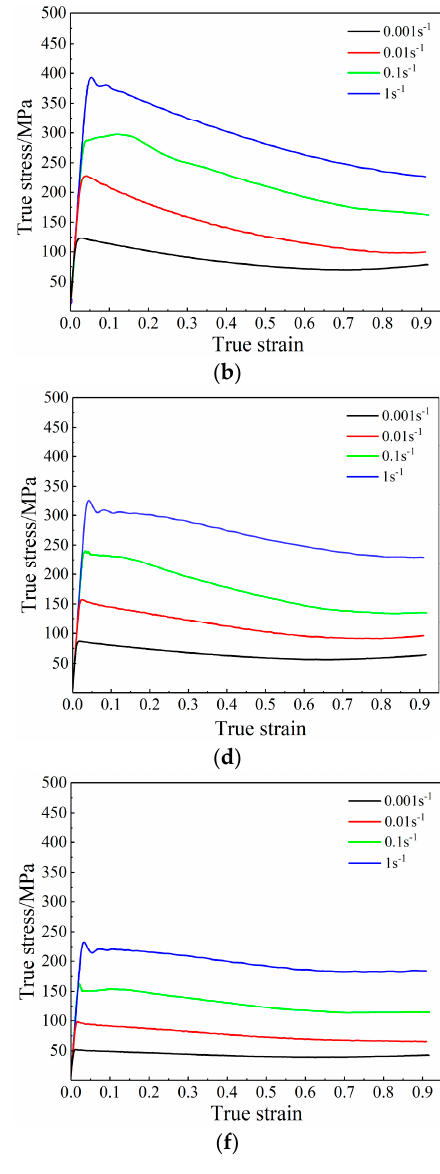
Figure 2. The true stress–strain curves of Ti-6554 alloy under deformation temperatures of ( a ) 715 °C; ( b ) 735 °C; ( c ) 755 °C; ( d ) 775 °C; ( e ) 810 °C; ( f ) 840 °C .